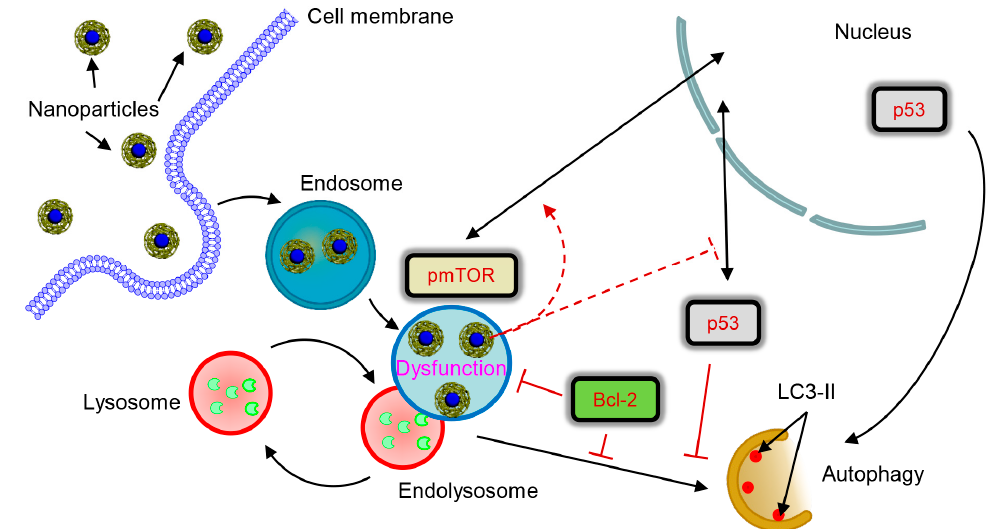
Figure 9. Scheme of lysosomal dysfunction upon nanoparticle treatment. Sub-lethal doses of iron oxide nanoparticles are endocytosed into lysosomes in hepatic cells within 12 h. Accumulation of nanoparticles in lysosomal compartments leads to progressive impairment of lysosomal function. The resulted lysosomal dysfunction probably affects sub-cellular localization of pmTOR and p53.